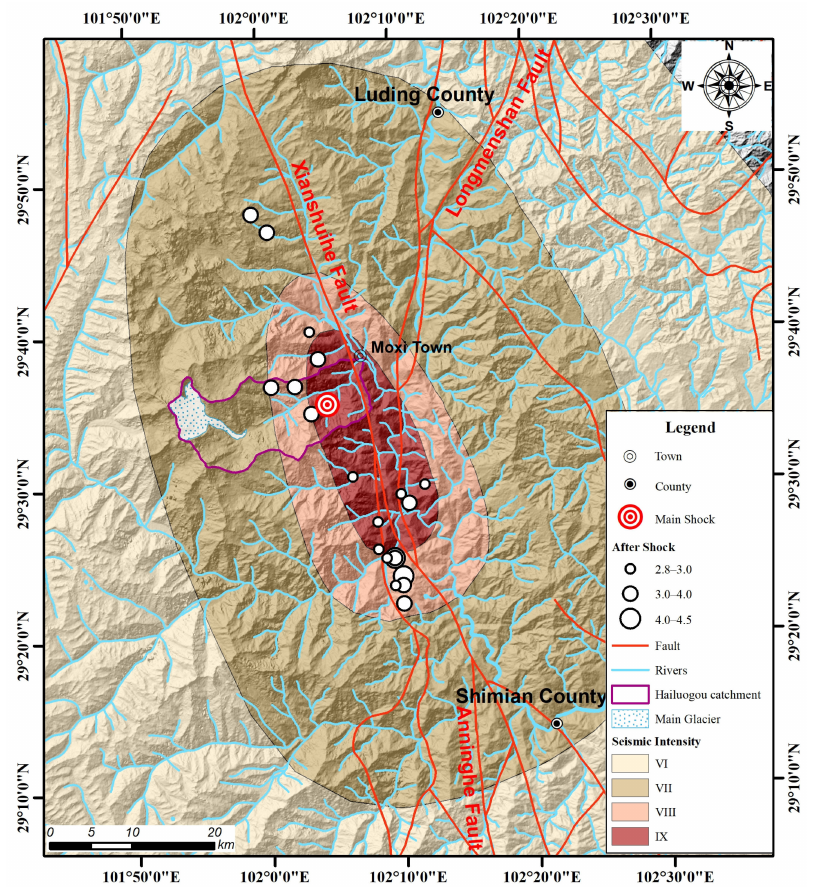
Figure 1. Geomorphologic and geological map of the Luding earthquake. The image of the fault is taken from the 1:500,000 geological map provided by the Sichuan Seismological Bureau, the seismic intensity information is taken from the Ministry of Emergency Management, and the seismic data are taken from the China Seismological Network